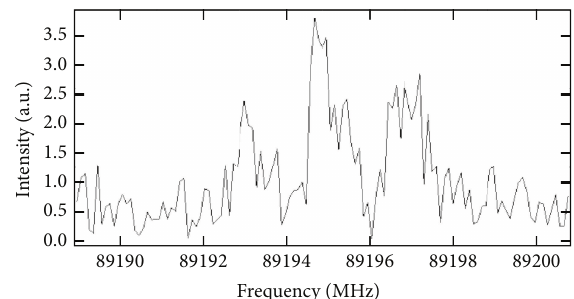
Figure 3: HCO + spectrum for G75.78+0.34 and G75.77+0.34 from BIMAobservations.Theintensitiesareshowninarbitrarycorrelator